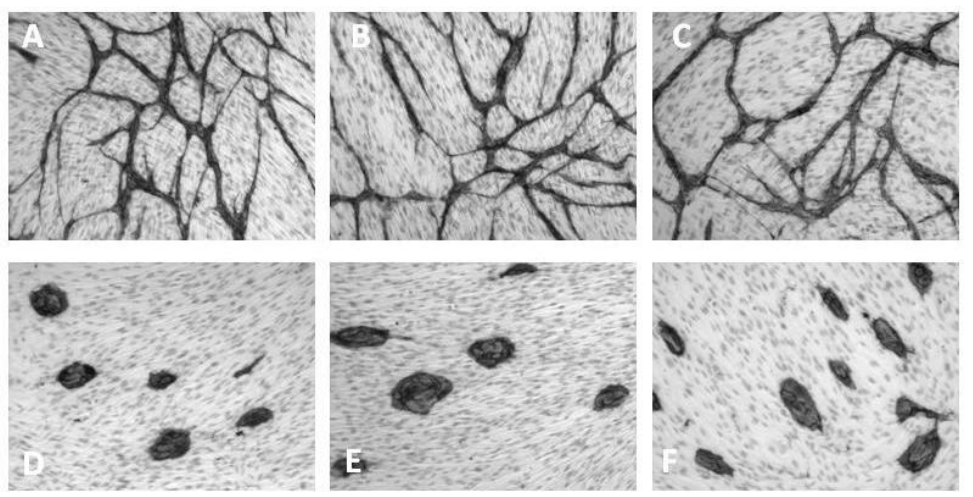
Figure 3. VEGF-dependent capillary-like tube formation of HUVECs propagated for three days in coculture with fibroblasts in ( A ) TFSM2 medium, ( B ) TFSM2 medium without bFGF, ( C ) TFSM2 medium + 20 µg/mL goat anti-bFGF, ( D ) TFSM2 medium without bFGF and VEGF, ( E ) TFSM2 medium without VEGF, ( F ) TFSM2 medium + 5 µg/mL goat anti-VEGF. Cell nuclei are counterstained with Mayer’s acid